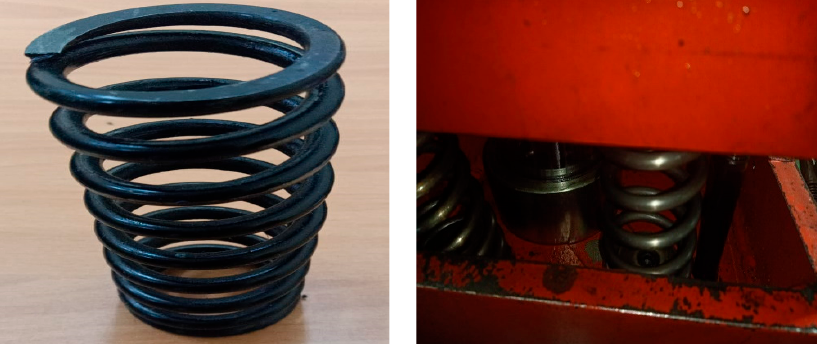
Figure 12. Spring installed in expanding machine.